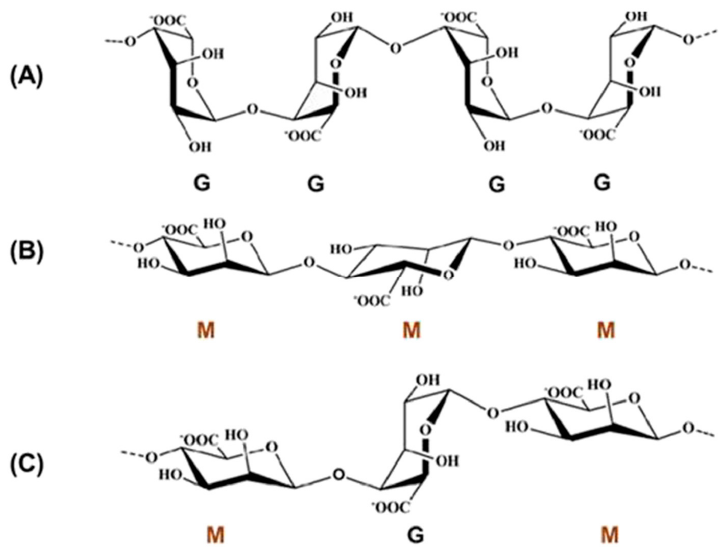
Figure 2. ( A ) Homopolymeric blocks of poly ‐α‐ 1,4 ‐ l ‐ guluronic acid (GG), ( B ) homopolymeric blocks of poly ‐β‐ 1,4 ‐ d ‐ mannuronic acid (MM), ( C ) heteropolymeric blocks of alternating M and G residues. Reproduced from [92] with permission.